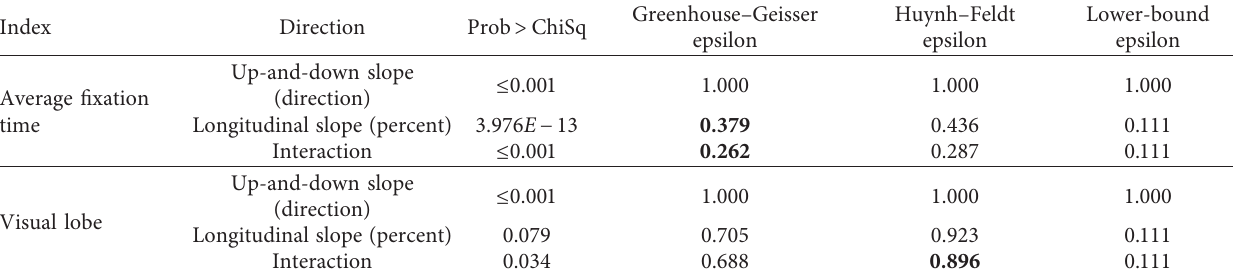
Table 6: Mauchly’s test of sphericity and evaluation of epsilon (two-way repeated measures